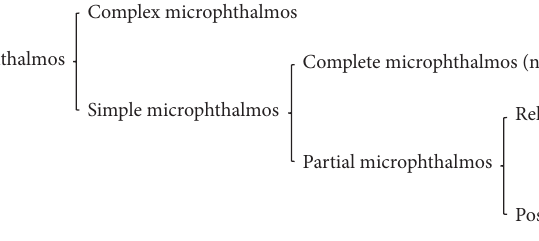
Figure 1: Clinical phenotypes of microphthalmos. Table 1: Comparison of three clinical phenotypes of simple